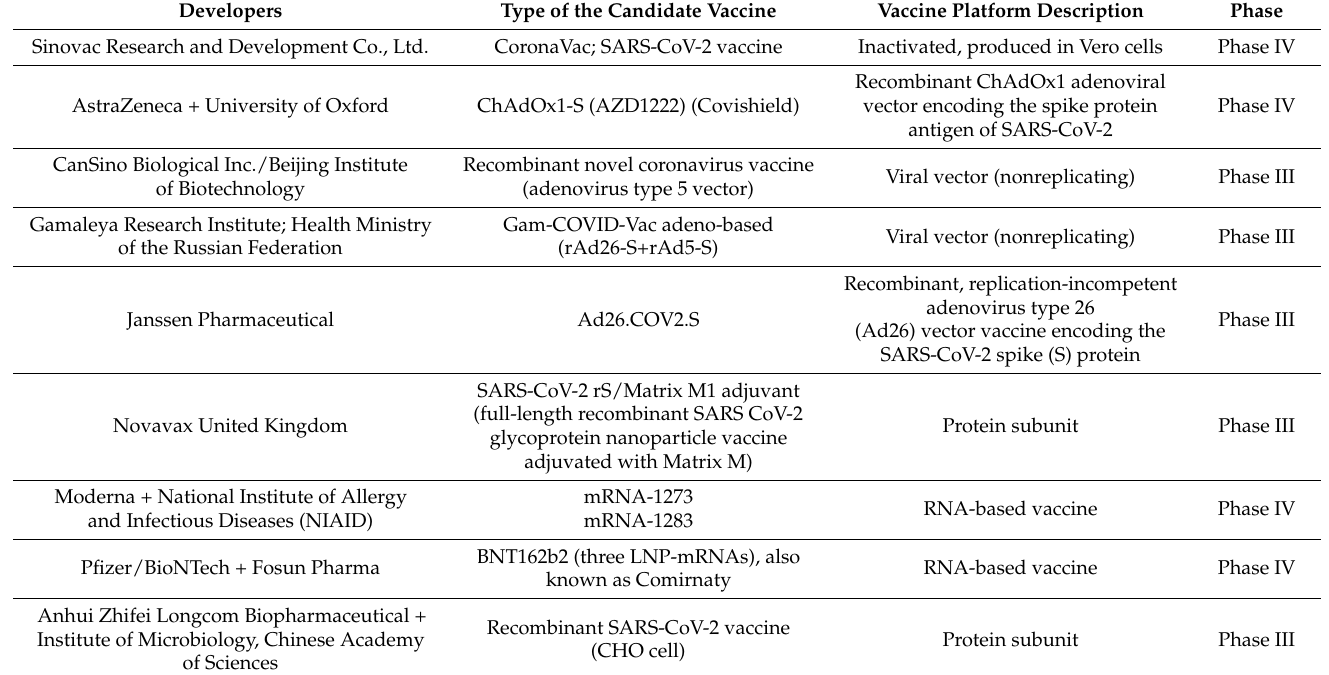
Table 1. Recent COVID-19 candidate vaccines and their status in clinical development. Developers